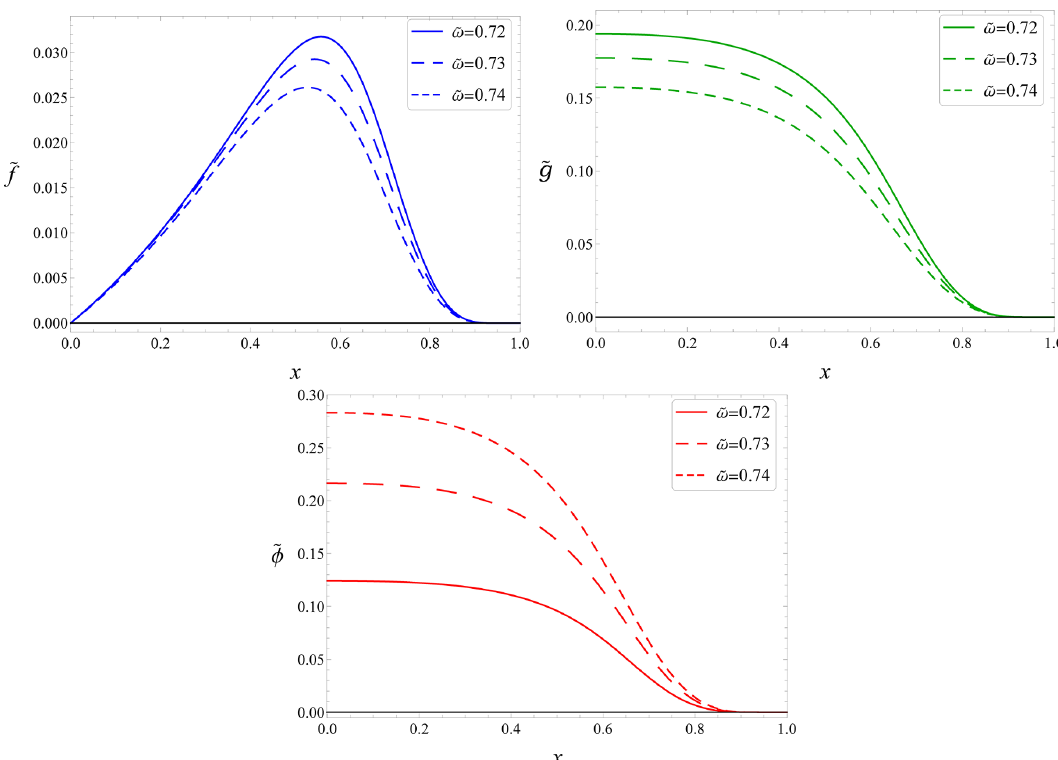
Figure 1. Dirac field functions ˜ f and ˜ g (top panels) and Scalar field function ˜ φ (bottom panel) as functions of x for ˜ ω = ˜ ω S = ˜ ω D = 0 . 72 , 0 . 73 , 0 . 74 . All solutions have ˜ µ D = 0 . 95 and ˜ µ S = 1